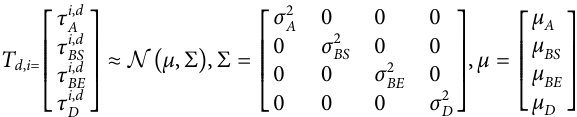
Frontiers in Energy Research |